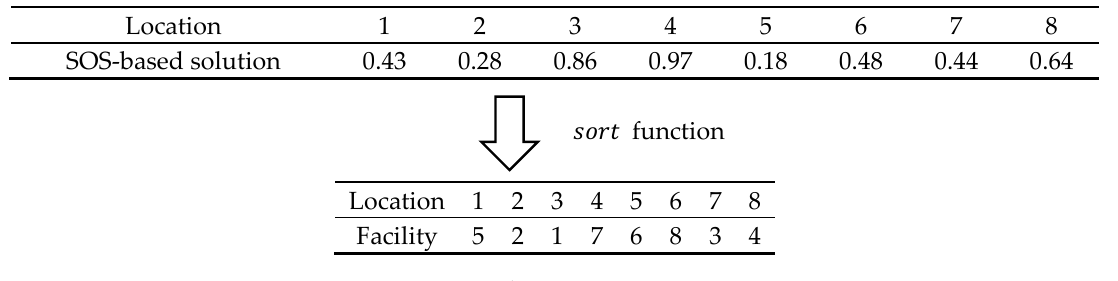
Figure 1. Solution representation.